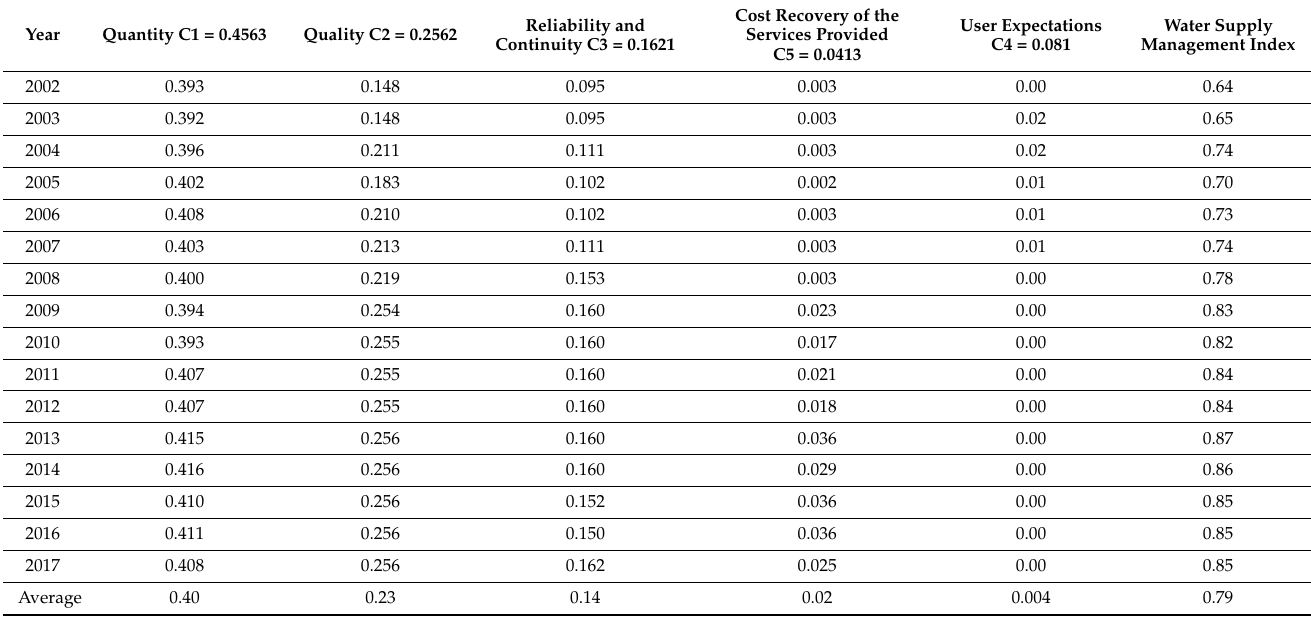
Table 4. Water Supply Management Index for Leon,